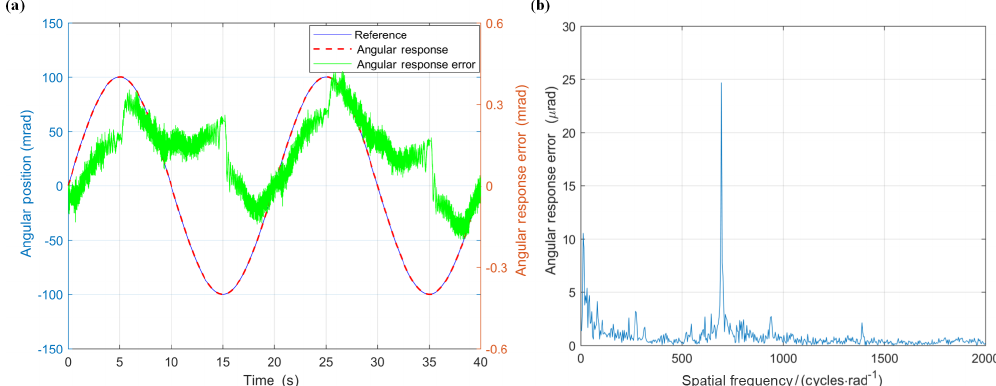
Figure 8. Positioning performance test results: (a) reference, angular response and position error to a sinusoidal excitation with the amplitude of 0.1mrad and frequency of 0.05Hz; (b) spatial frequency spectrum of transmission error.